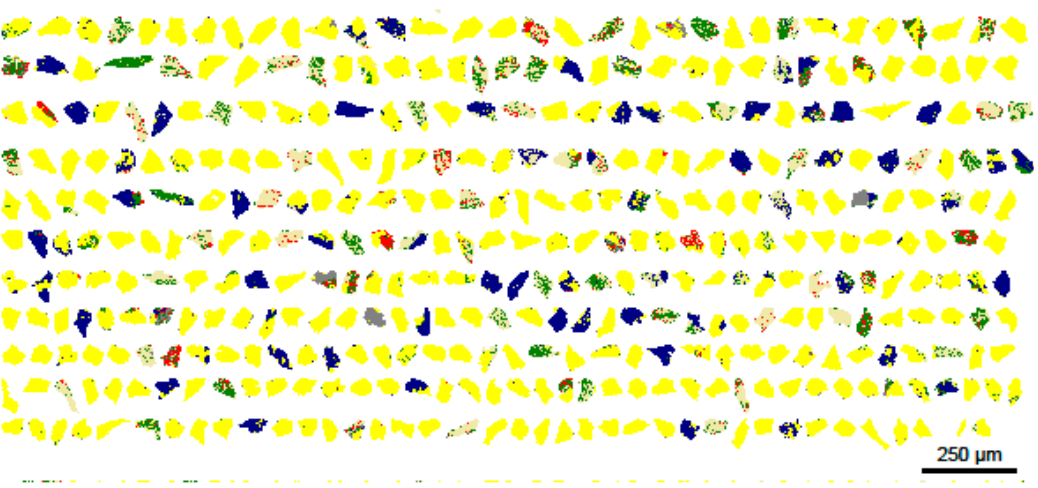
Figure 19. QEMSCAN false-color images of the various mineral particles in the discard of the gravity upgrade. Note that the sulphides (yellow), although liberated, are much finer-grained than those shown in Figure 18 (product prior to upgrading).